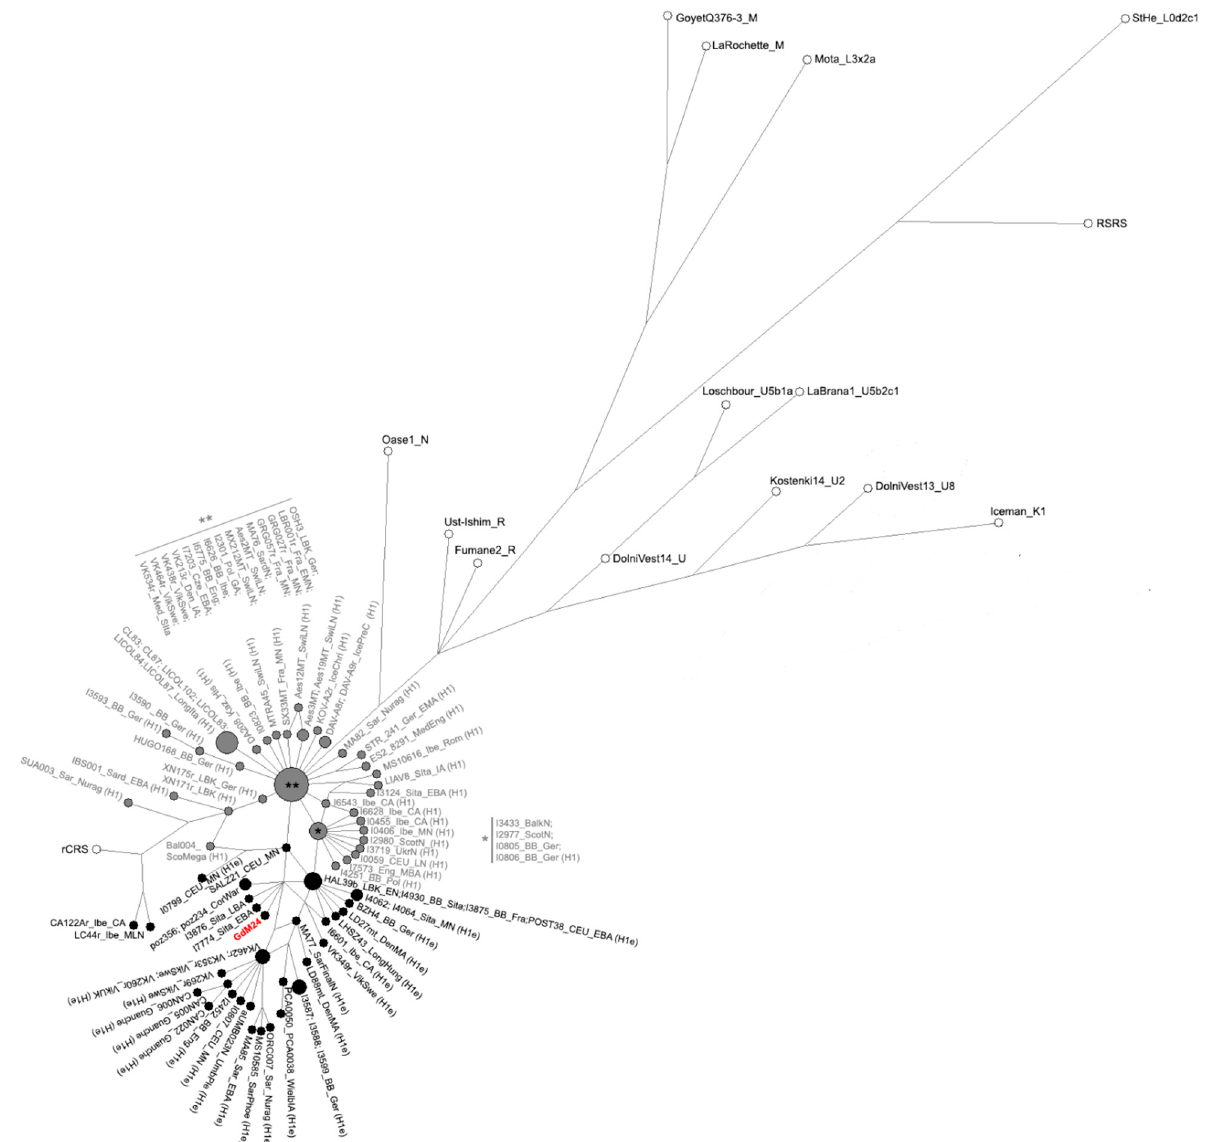
Figure 2. Median Joining Network based on the complete GdM24 mitogenome (shown in red) compared to a dataset of ancient reference (in white), H1 (grey) and H1e (black) mitogenomes (see Table S4 for dataset).